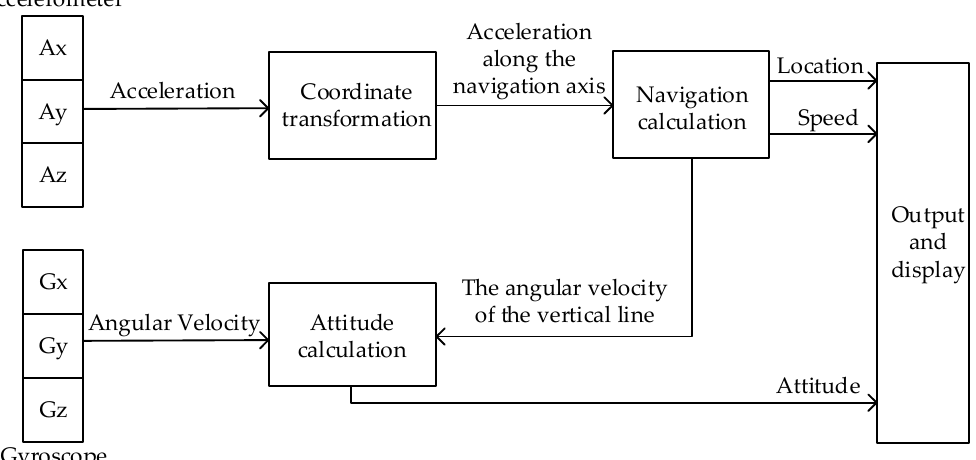
Figure 1. The schematic diagram of the strapdown inertial navigation system.